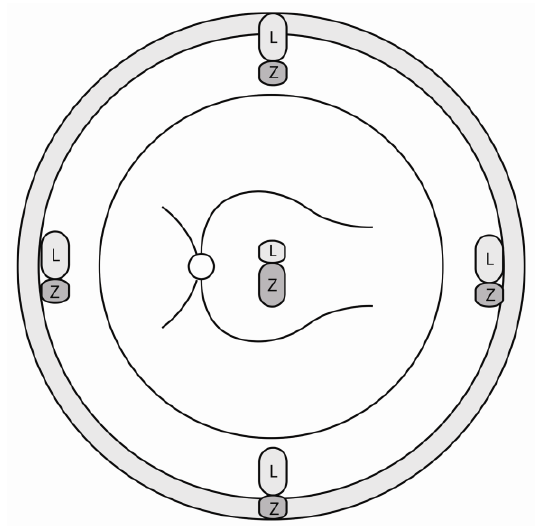
Figure 1. Schematic representation of the ratio of lutein to zeaxanthin in central and peripheral retina; L: lutein; Z: